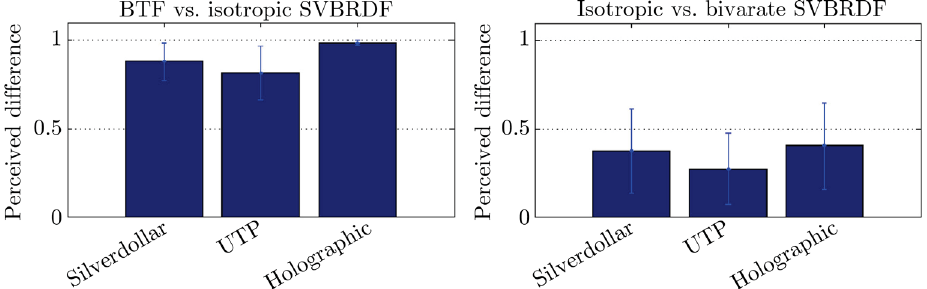
Fig. 10 Perceived differences between uniform BTF and isotropic SVBRDF measurements (left), and isotropic and bivariate isotropic SVBRDFs (right), both with step 5 ◦